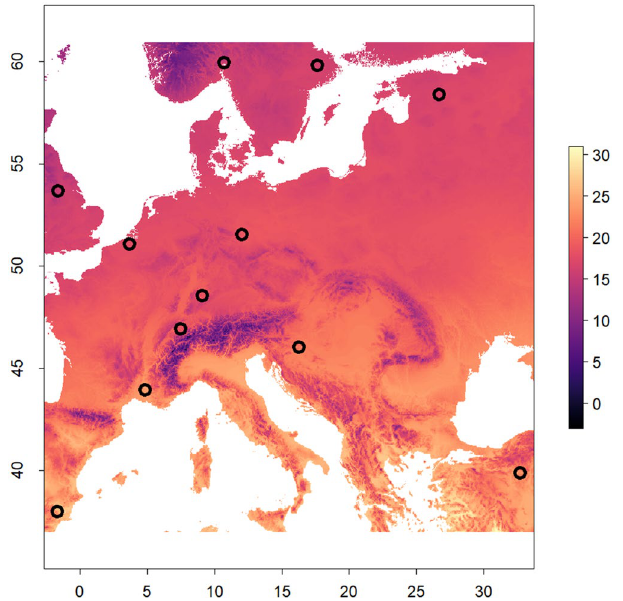
Figure 1. Map with the geographical distribution of the 12 sample sites (indicated with black circles) across Europe with color representing the climatic gradients (mean temperature of the warmest month [°C], as an example). Map created using R (version 4.0.4) 51